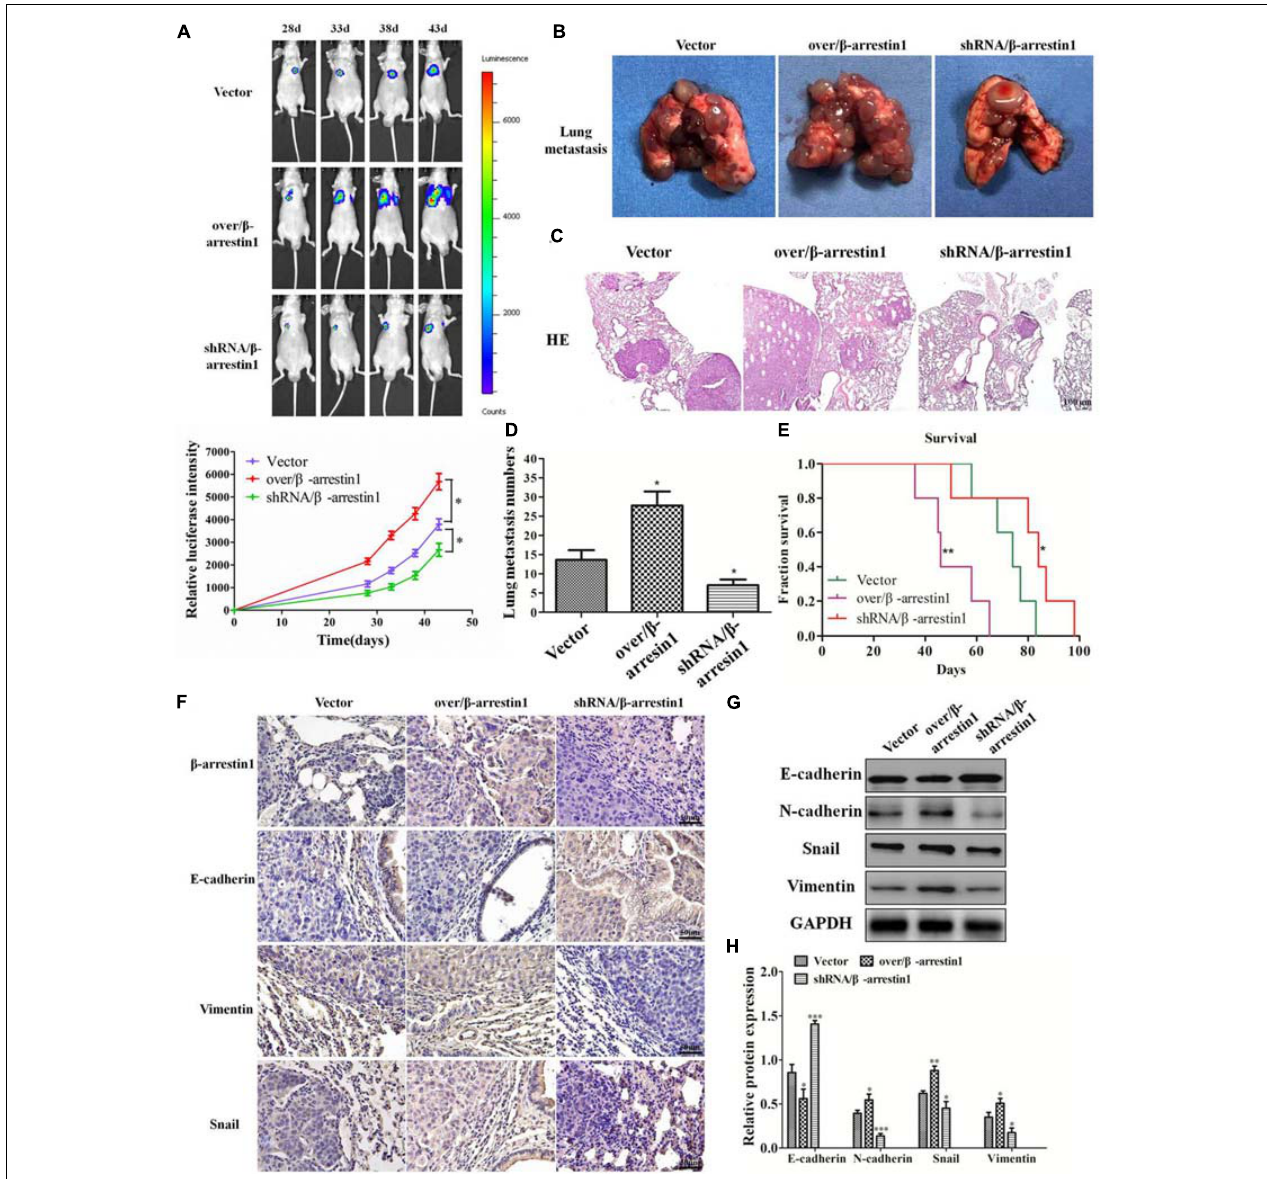
FIGURE 7 | β -arrestin1 regulates CRC EMT and metastasis in vivo . (A) Fluorescence intensity was evaluated in eight mice of each group at days 28, 33, 38 and 43 after tail vein injection. * P < 0.05 vs. HCT-116-vector group. (B–E) The lung metastasis tissues were excised after day 43, and the number of metastatic lesions was counted. * P < 0.05 vs. HCT-116-vector group. The survival curve of animals injected with HCT-116/luc or shRNA/ β -arrestin1-HCT-116/luc or over/ β -arrestin1-HCT-116/luc cells. * P < 0.05; ** P < 0.01 vs. HCT-116-vector group. Representative hematoxylin and eosin staining of tumor cytostructure and cytomorphology analysis. (F) Immunohistochemistry detected the expression levels of β -arrestin1, E-cadherin, Vimentin and Snail in three groups. (G,H) The protein expression levels of E-cadherin, N-cadherin, Snail and Vimentin were examined via western blotting. * P < 0.05; ** P < 0.01, *** P < 0.001 vs. HCT-116-vector